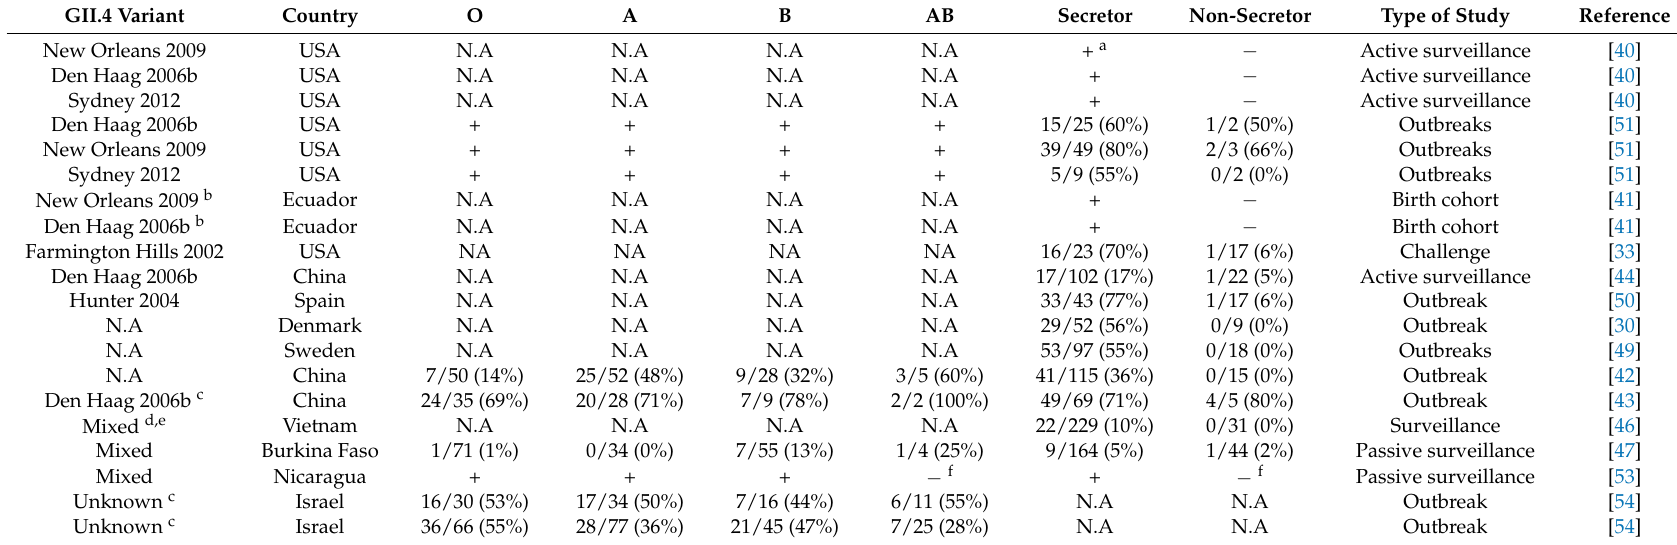
Table 3. Distribution of ABO and secretor status in studies with GII.4 genotype infections (symptomatic and asymptomatic). Only included are studies and/or genotypes with at least five representative